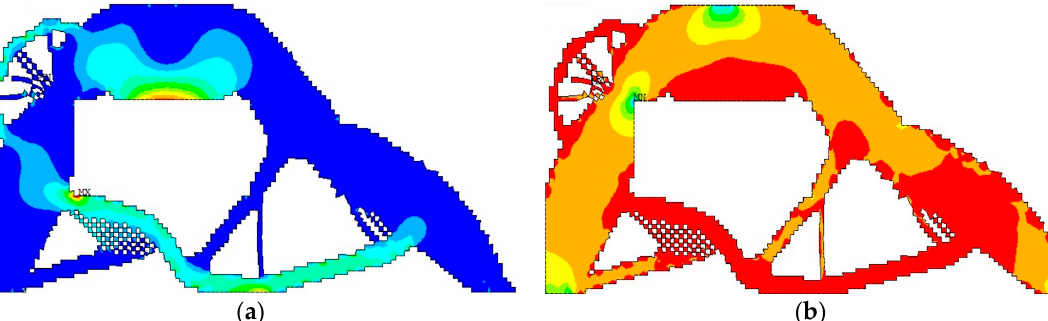
Figure 5. Stress contour plots of the Group A irregular concrete deep beams with optimal topology: